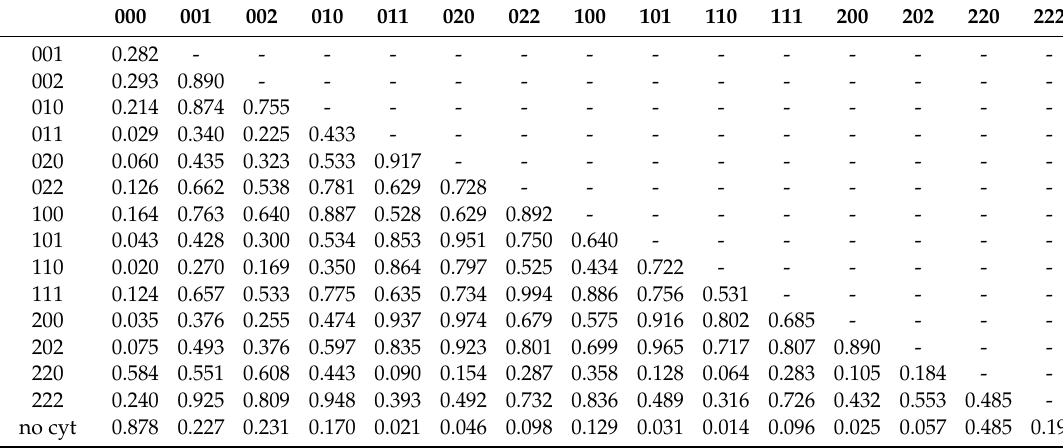
Table 1. Pairwise t -tests for the growth rates between the 16 conditions, using the growth rate data shown in Figure 1. p -values are shown at the intersection of the row and column for each condition pair. The table was generated using R studio’s “pairwise.t.test” command, and the assumptions of normality and homogeneity of variances were verified using the Shapiro-Wilk and Bartlett tests, respectively. Statistical di ff erences between means were identified for α <